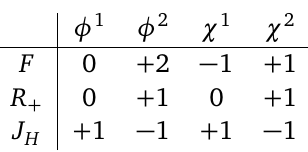
Table 3: Weights of hypermultiplet fields in the B